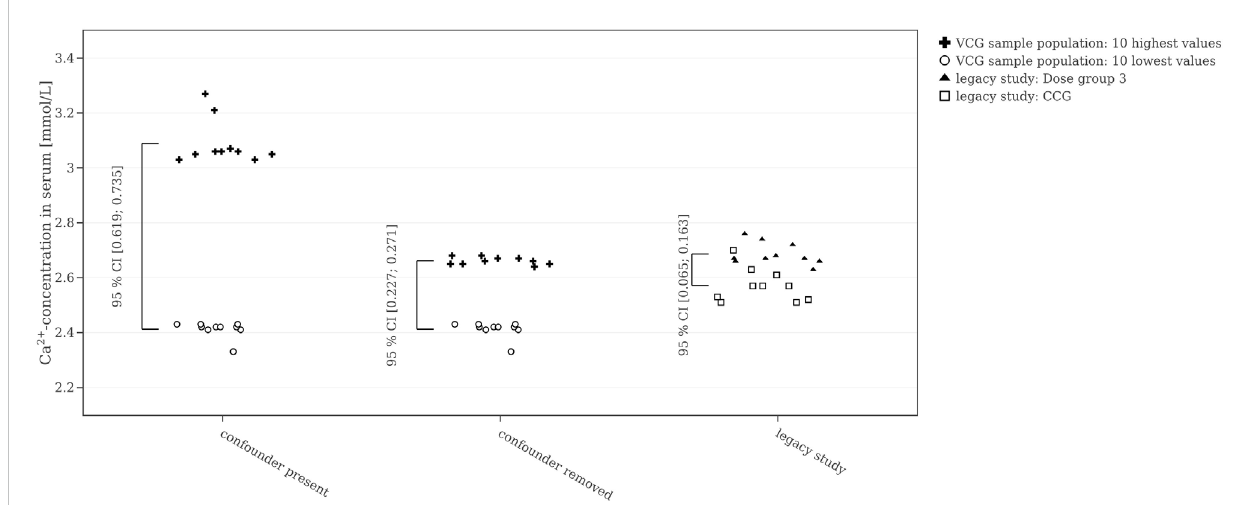
FIGURE 8 10 highest and 10 lowest calcium values of the Virtual Control Group (VCG) sample population (once with and once without the values affected by theconfounder)comparedtotheConcurrentControlGroup(CCG)andDosegroup3ofthelegacystudy.The95%con fi denceintervalforthedifference in means is shown for each